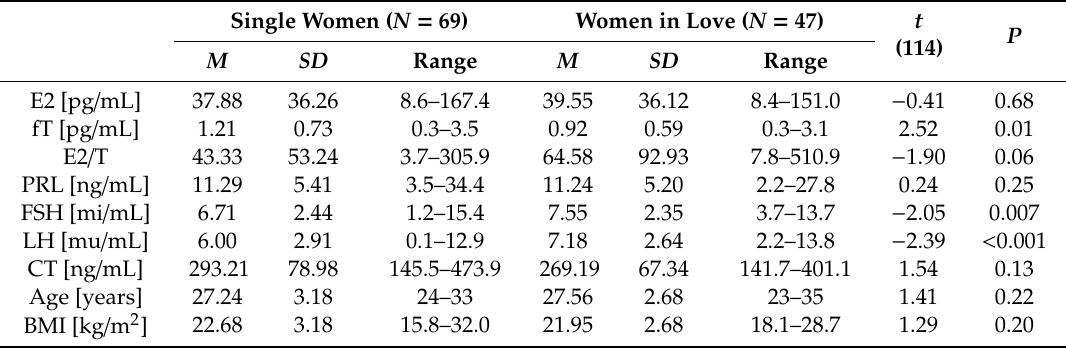
Table 1. Comparison of estradiol (E2, and E2 / T), free testosterone (fT), prolactin (PRL), gonadotropin (FSH, LH), and cortisol (CT) levels between single women ( N = 69) and women in love ( N = 47). Descriptive statistics (mean, standard deviation, and range) and pairwise comparisons are also given for control variables (age and BMI). Means, SDs, and ranges are given for non-transformed values. Single Women ( N =